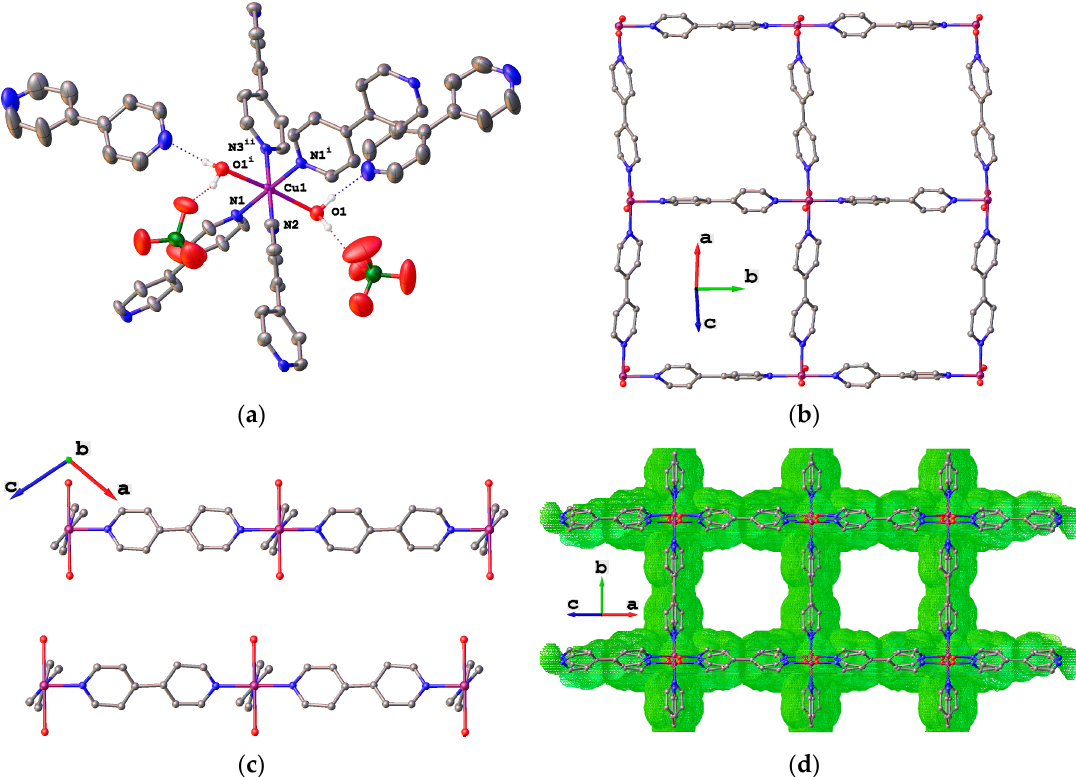
Figure 3. ( a ) Coordination environment of the copper center in compound 5 (thermal ellipsoids drawn at the 50% probability level). ( b ) 2D network (single layer); ( c ) view along the ac plane of alternating and slightly mismatched grids; ( d ) channels formed by the 2D layers (green points). Color code: Cu, purple; O, red; N, blue; C, grey; Cl, green; H, white. Anions, uncoordinated bpy molecules and H atoms omitted for clarity in the packing figures. Symmetry operations: i = 1/2 − x , + y , 1/2 − z ; ii = + x , − 1 − y , + z .